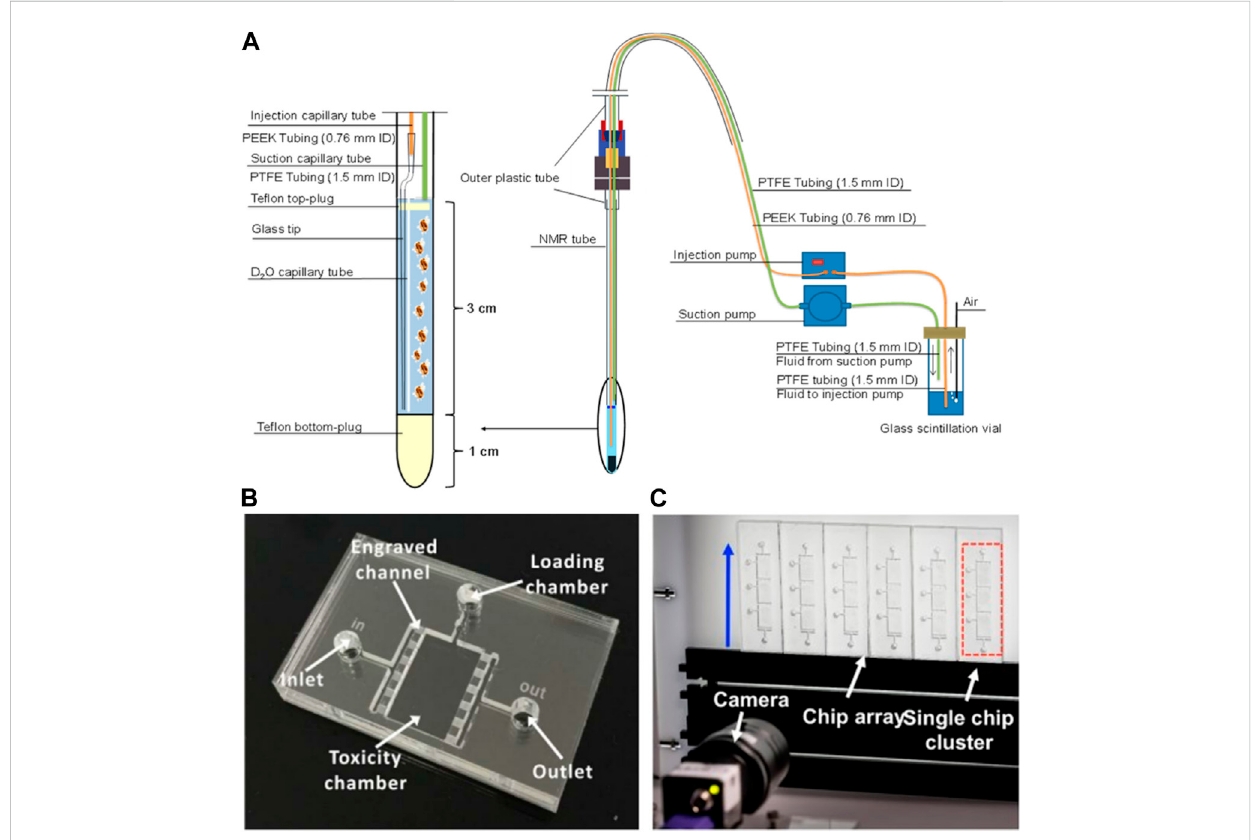
FIGURE 4 (A) Low-volume fl ow system for D. magna in vivo NMR (Tabatabaei Anaraki et al., 2018); (B) micro fl uidic chip for D. magna toxicity testing (Huang et al., 2015); (C) Photograph of the system setup consisting of a milli fl uidic chip-based array, fl uid actuation and optical detection modules (Huang et al., 2017). Reproduced with permission from SCRIP and SPIE,